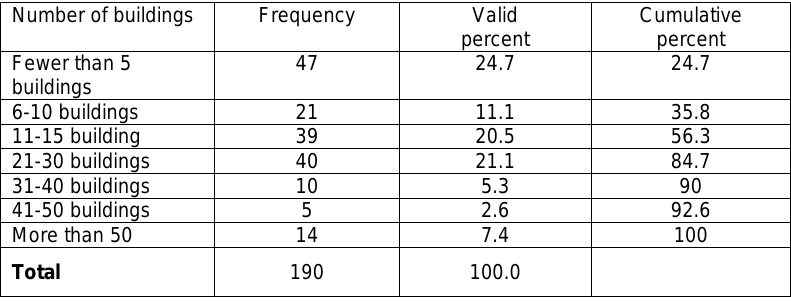
Table 4: Analysis of the number of hospital building being managed by maintenance departments